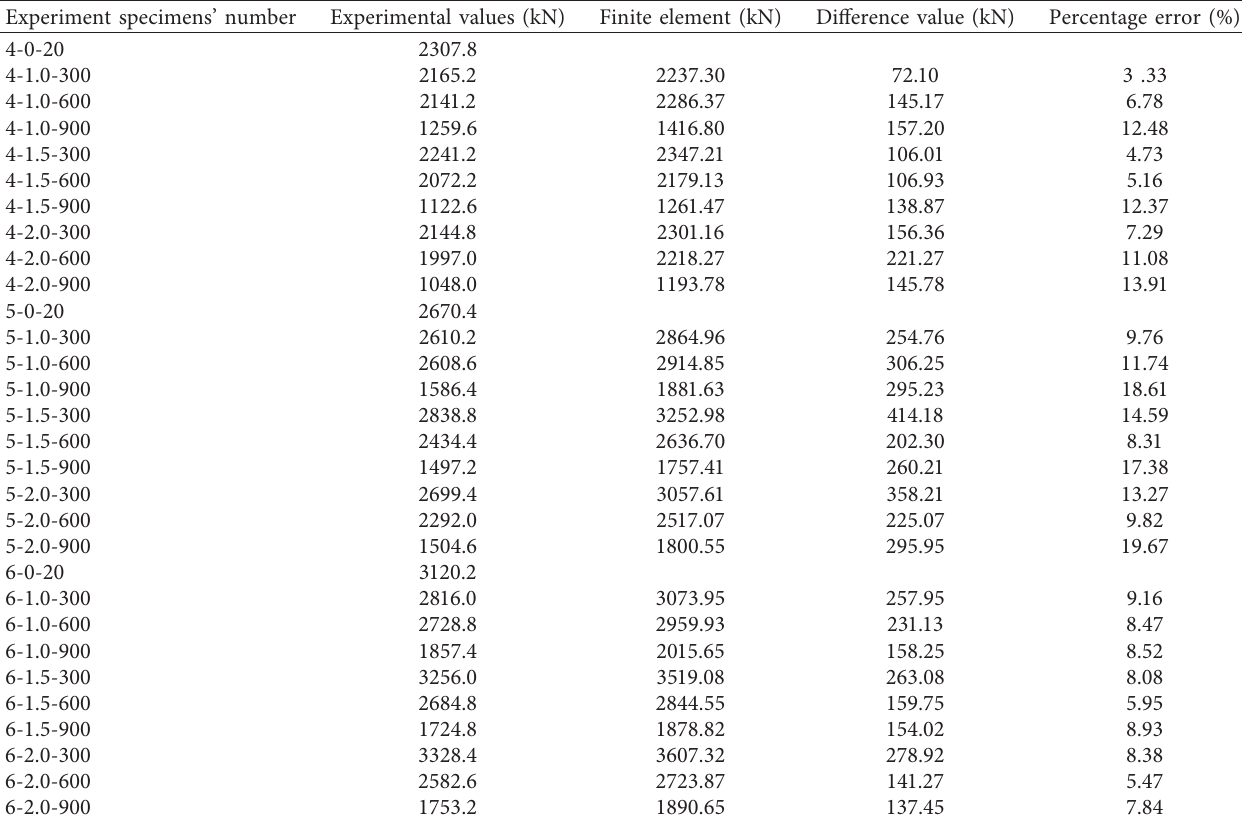
Table 7: Comparisons of ultimate bearing capacity and finite element bearing capacity. Experiment specimens’